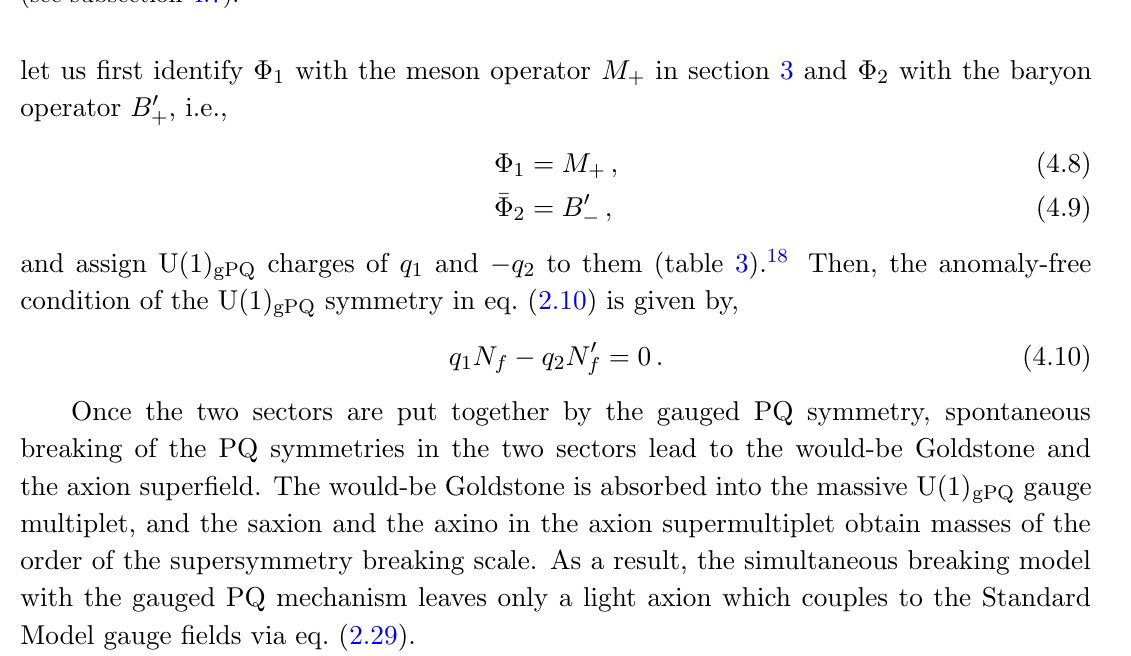
Table 3 . The charge assignment of the gauged PQ symmetry and the Z 4 R symmetry. The singlet (cid:12)elds Y ’s and Y 0 ’s are introduced to cancel the self-triangle and gravitational anomalies of U(1) gPQ (see subsection